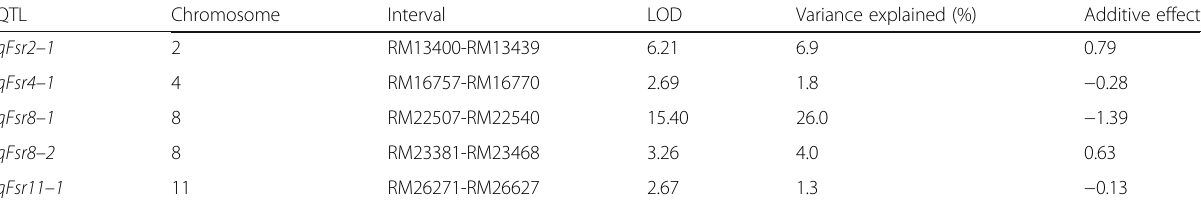
Table 3 Quantitative trait loci controlling false smut resistance identified in the RIL-F 7 population